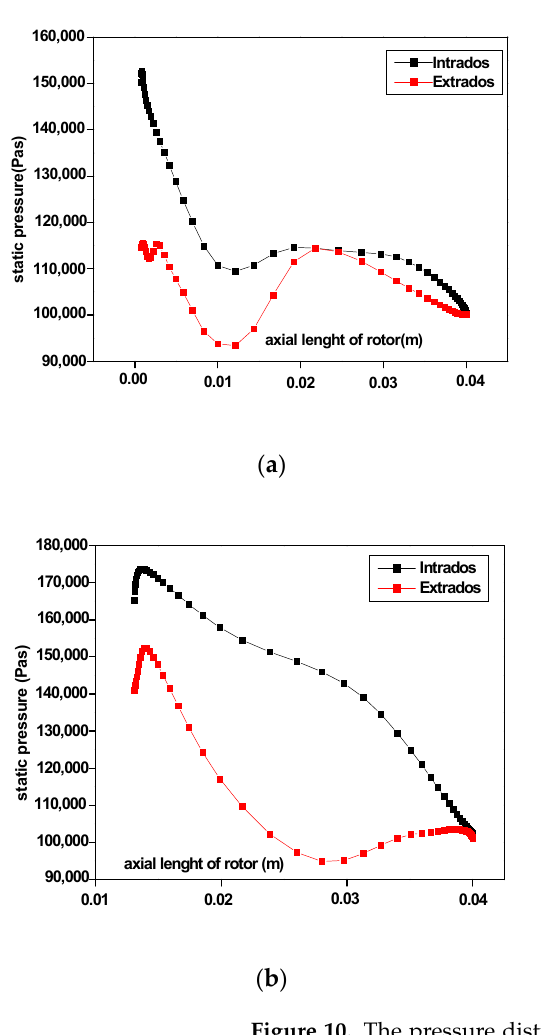
Figure 10. The pressure distributions around the blade profiles: ( a ) static pressure near the hub; ( b ) static pressure near the shroud; ( c ) static pressure in the mean radius.